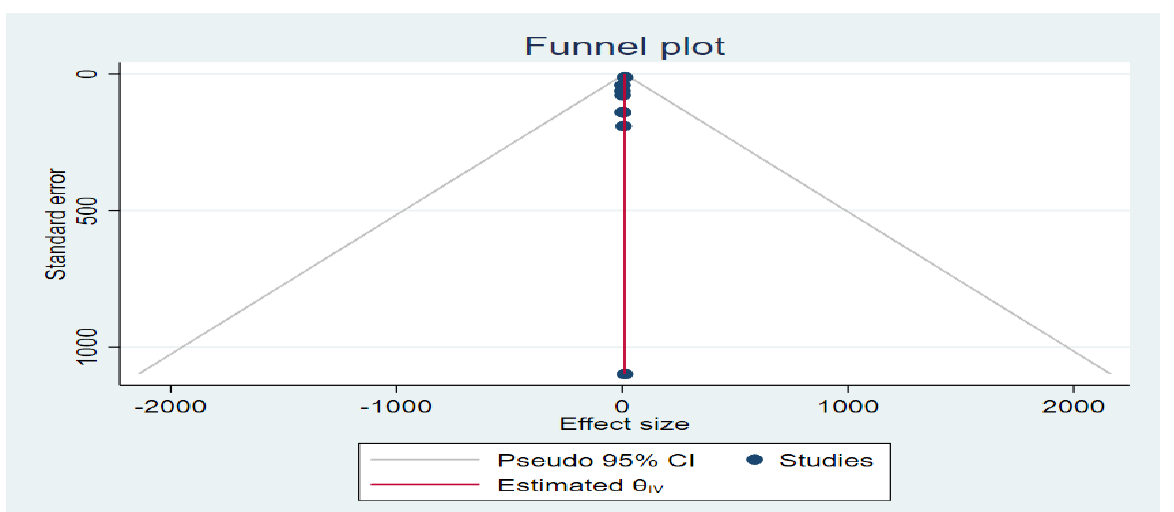
Figure 5. Funnel plot of the prevalence of the chronic obstructive pulmonary disease amongst the COVID-19